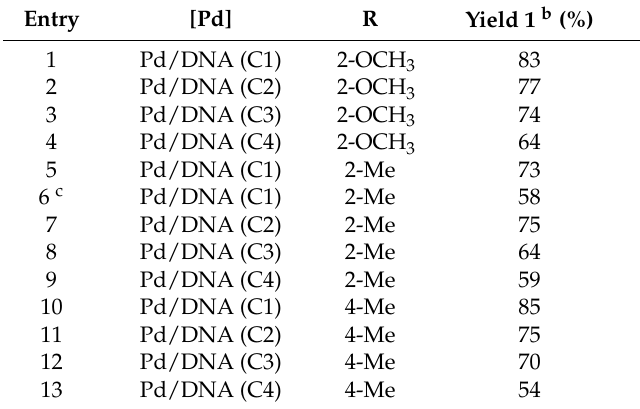
Table 1. The Suzuki–Miyaura coupling of various aryl bromides and phenylboronic acid catalyzed by the catalysts C1–C4 a .